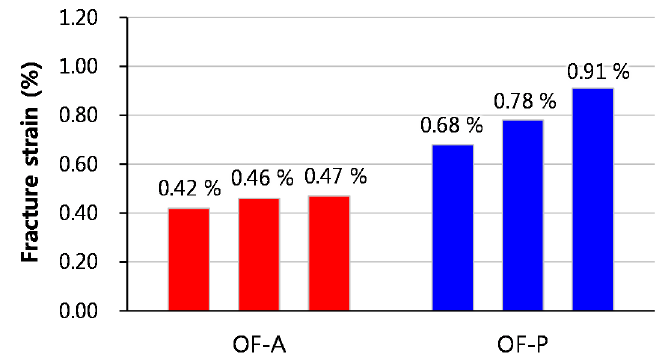
Figure 9. Fracture strains of optical fibers embedded in a strand according to the recoating material used.